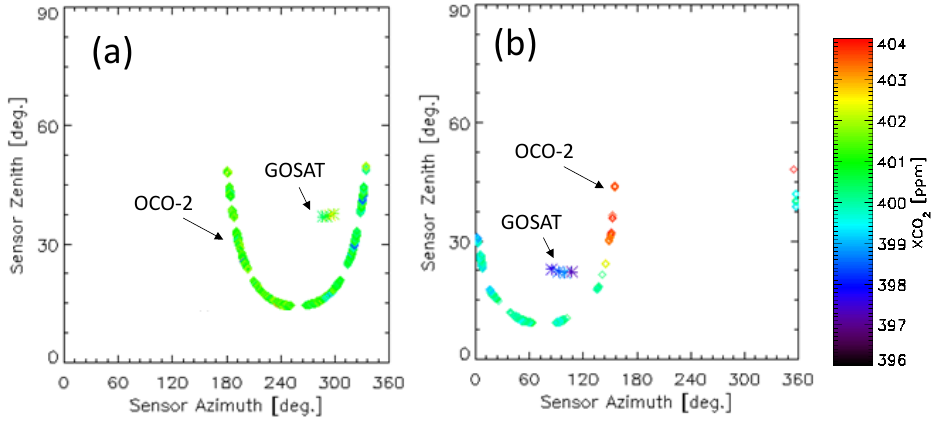
Figure 12. The OCO-2 and GOSAT retrieved XCO 2 against satellite azimuth and zenith angles during RRV target observations on ( a ) 29 June 2015 and ( b ) 1 July 2015.